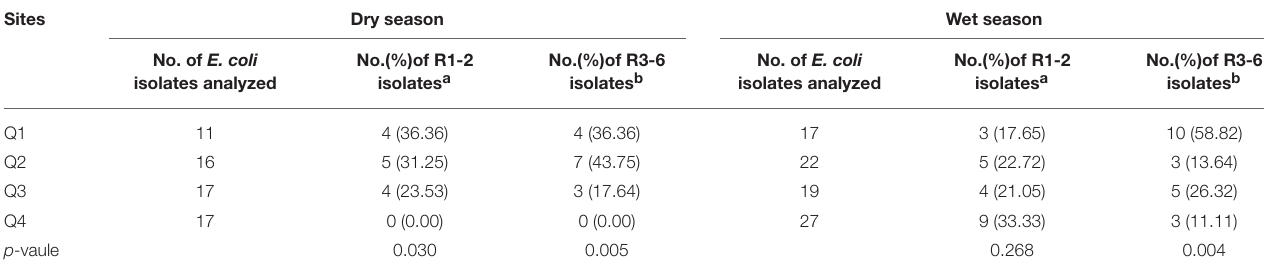
TABLE 4 | The distribution of antibiotic resistance rate for R1-2 and R3-6 subpopulation isolated from the Qiantang River in two seasons.